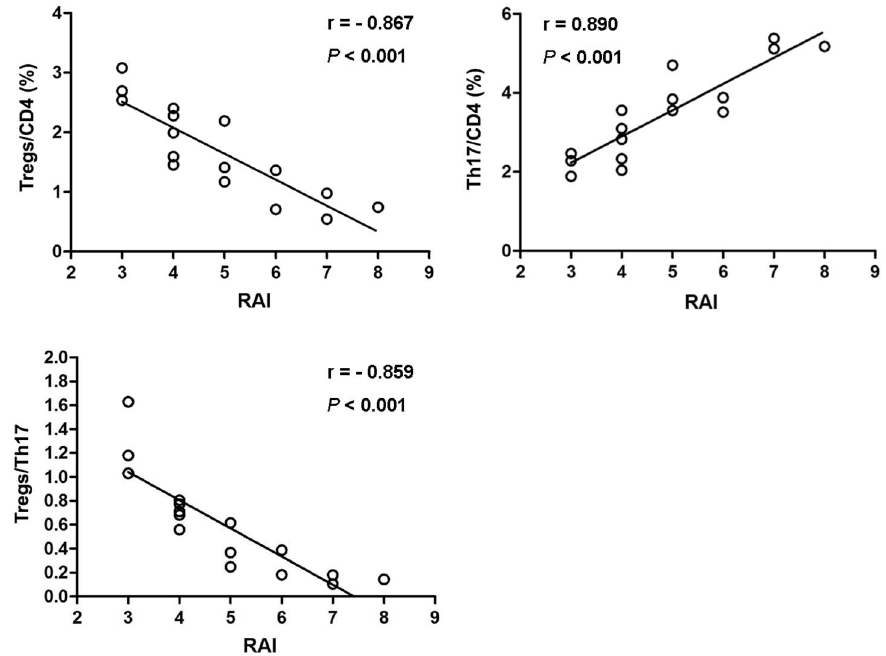
Figure 3. The frequency of Tregs, the frequency of Th17 cells, and Tregs/Th17 ratio are correlated with RAI. To confirm whether Tregs, Th17 cells and Tregs/Th17 were associated with the liver allograft rejection, we analyzed the correlation between RAI and the frequency of circulating Tregs, the frequency of circulating Th17 cells, and Tregs/Th17 ratio. We found that the Tregs level and Tregs/Th17 ratio had a negative correlation with RAI, whereas the Th17 cell level showed a positive correlation with RAI ( P , 0.01).